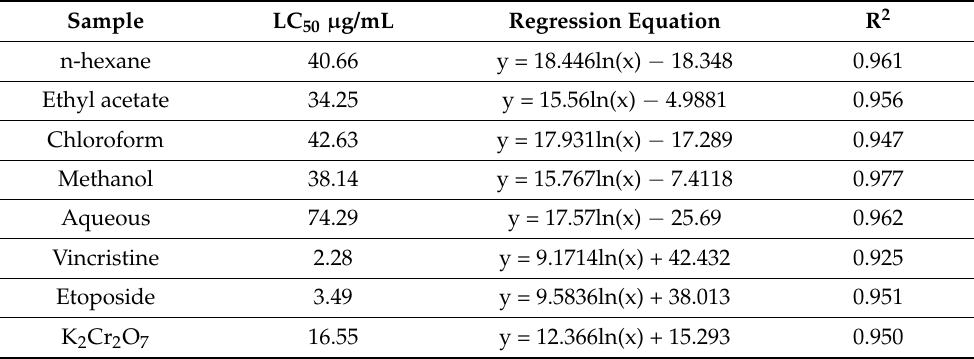
Table 1. Cytotoxicity of different fractions of P. harmala (S) extract; LC 50 and R 2 values determined through logarithmic regression analysis.